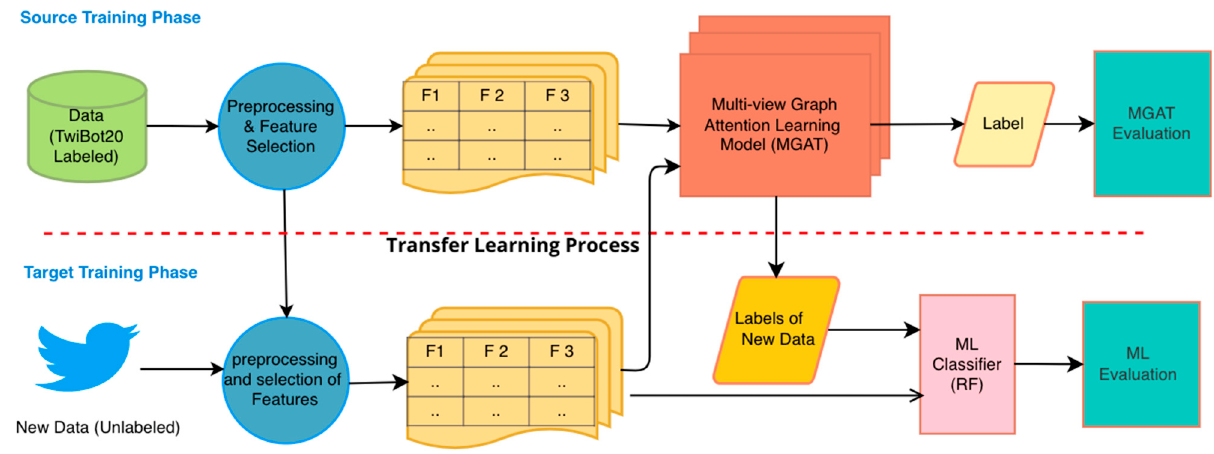
Figure 4. Bot-MGAT model architecture using the transfer learning approach.